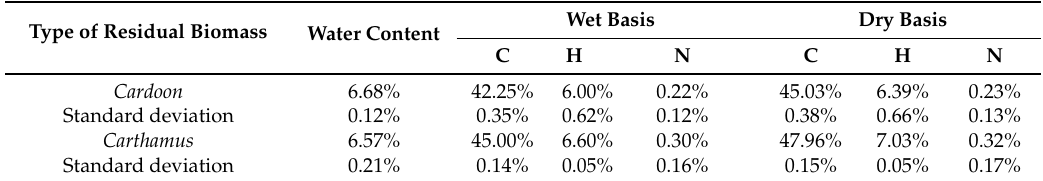
Table 2. Chemical characterization of the residual biomass ( cardoon and carthamus ) carried out by the CRB/CIRIAF Lab.